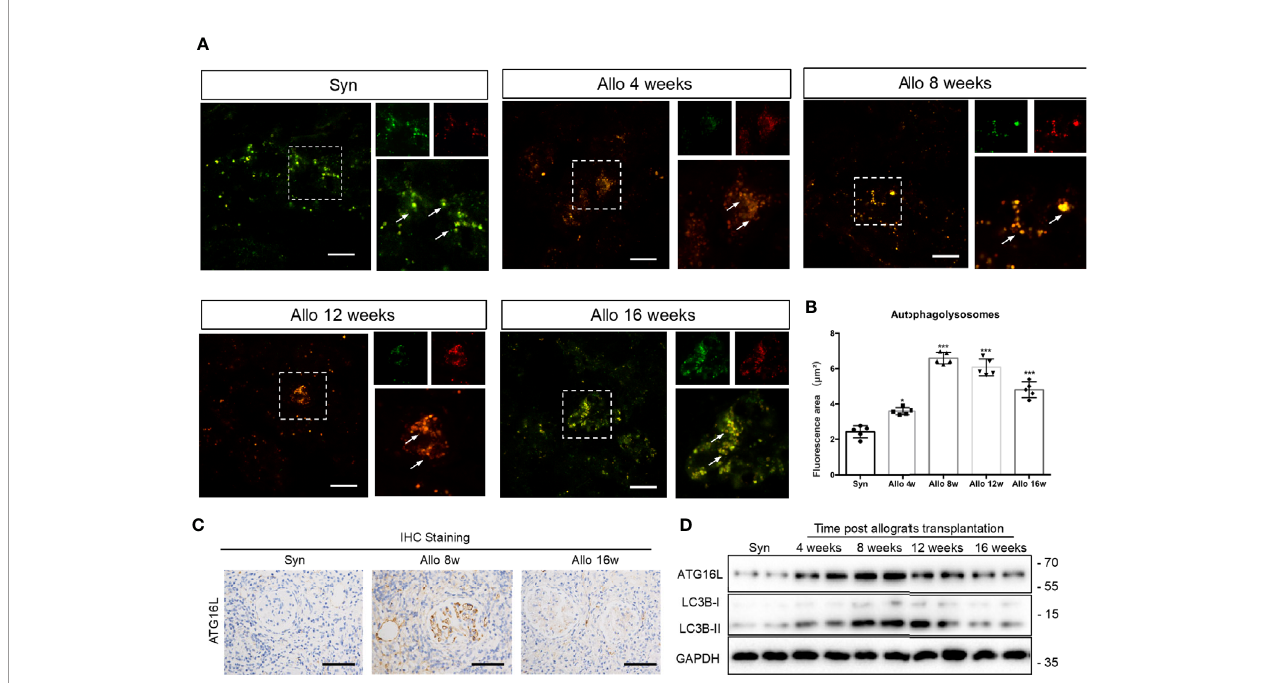
FIGURE 6 | Changes of autophagy activity in chronic rejection rat models. (A) Representative images of cortical kidney sections obtained from syn and different periods after kidney transplanted rats injected with AAV-mRFP-GFP-LC3. Arrows indicated the glomerular site. Scale bar: 20 m m (B) Semi-quanti fi cation analyses of the percentage of autolysosomes (red puncta/total puncta) in the images. The data were presented as mean ± SD (n = 5, *** P < 0.001, * P < 0.05, vs. the syn group). More than 100 cells were quanti fi ed for each image in each experiment. (C) Representative IHC staining images of ATG16L expressions in syn group, 8 weeks and 16 weeks allo group rats. (n=5) (D) Representative western blot assay results of ATG16L and LC3BI/II levels in kidney tissue from syn and allo group rats.